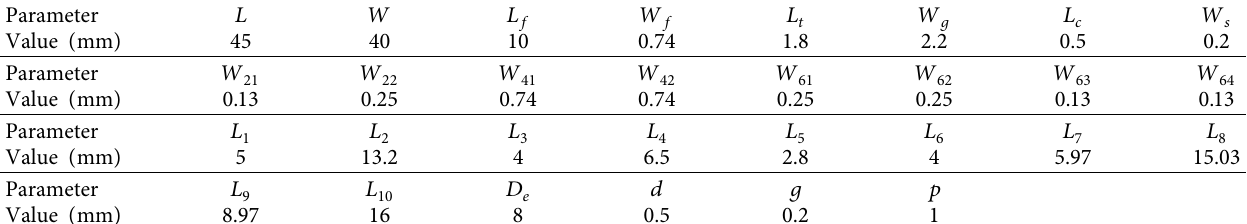
Table 2: Parameters of the proposed array.